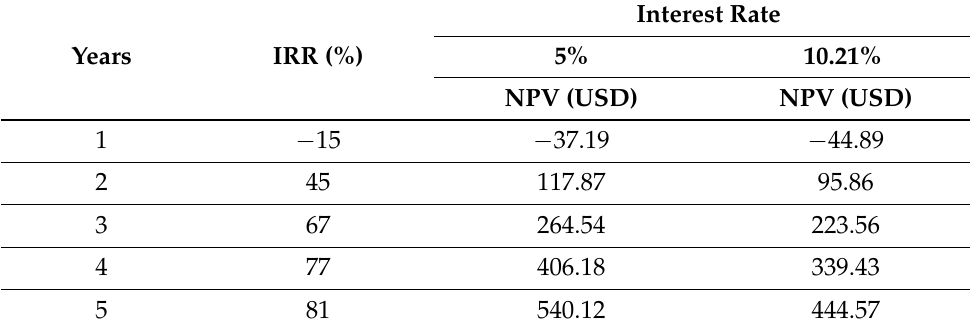
Table 4. Sensitivity analysis of second proposal.